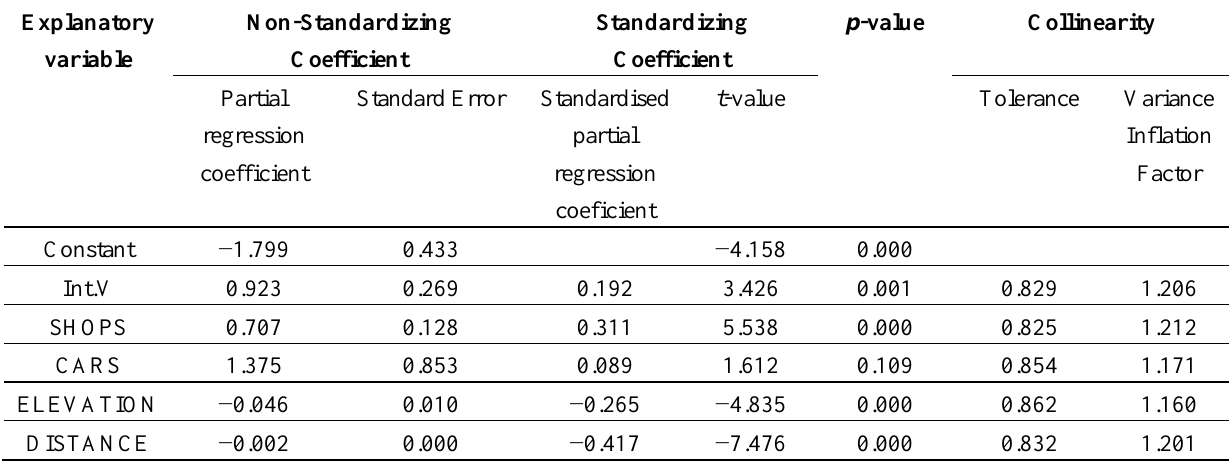
Table 5. Details of the distribution